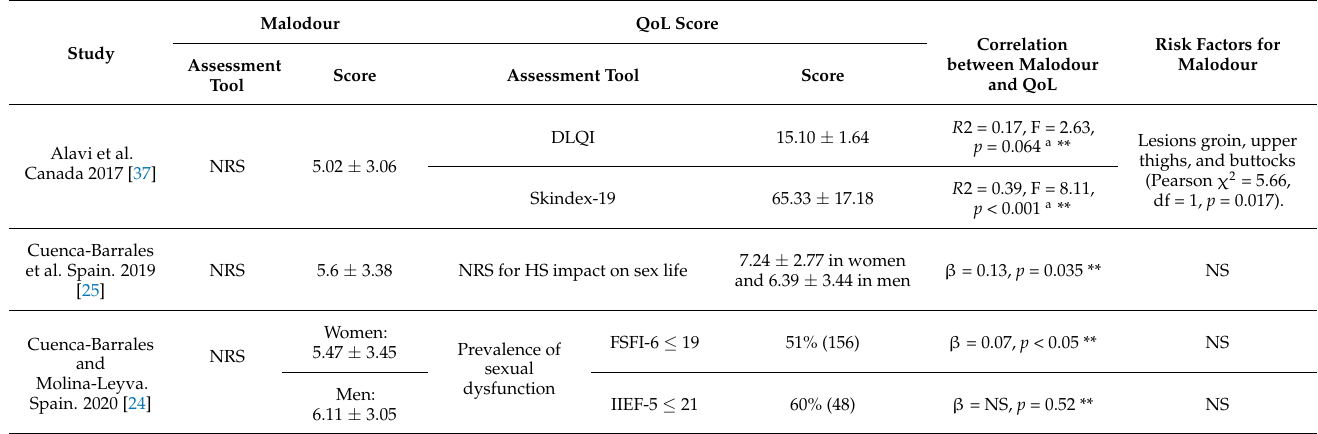
Table 4. Studies regarding malodour impact on